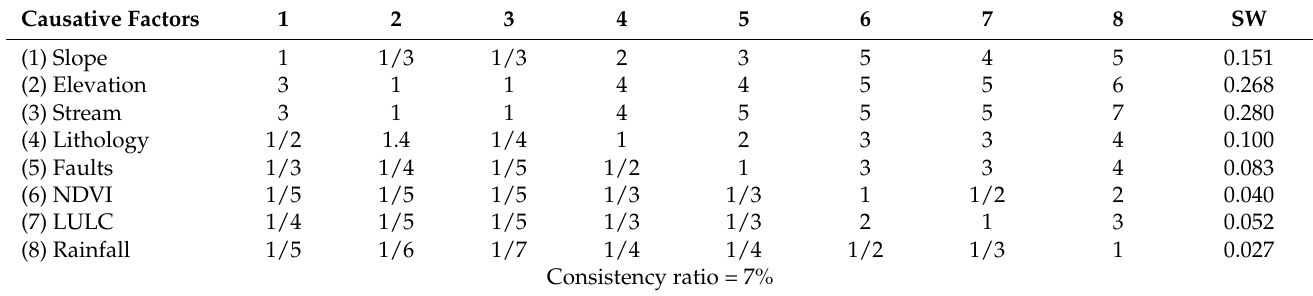
Table 16. Detailed AHP matrices for SWs of the flood causative